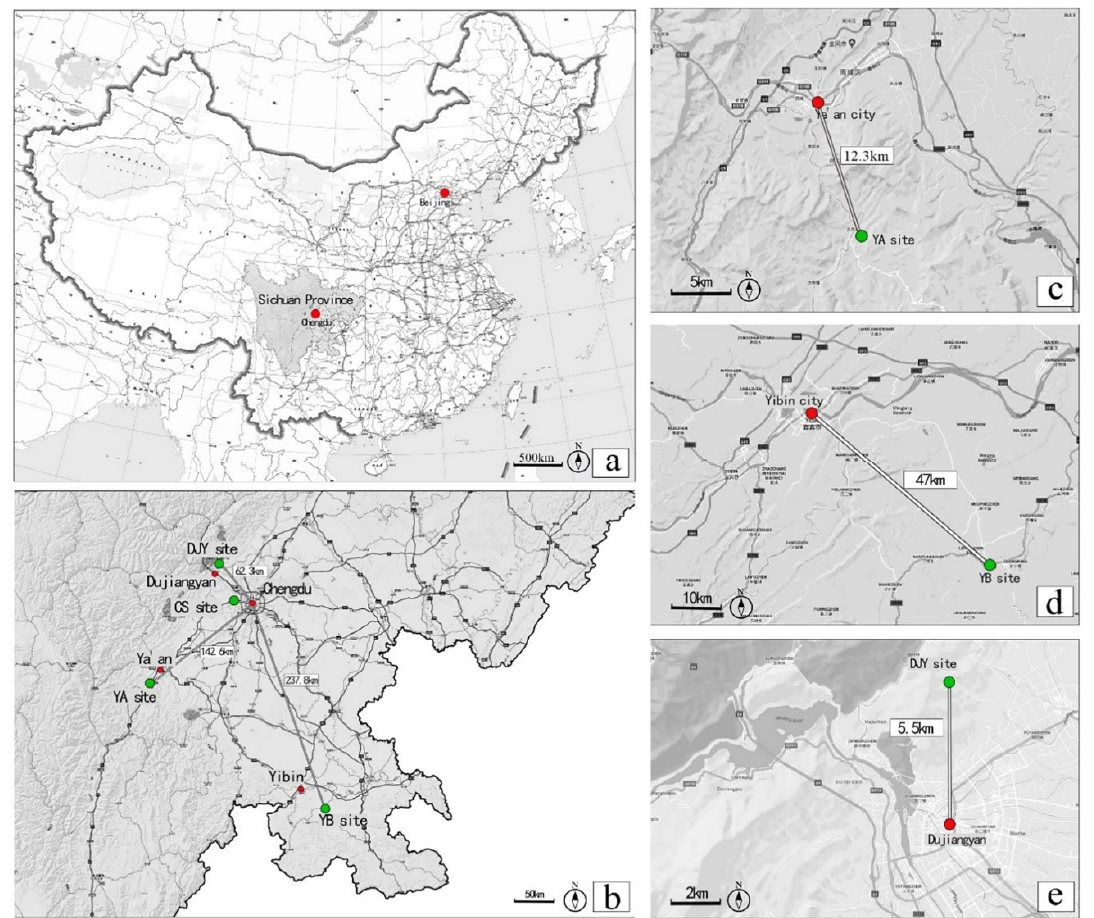
Figure 1. Maps of experimental sites. ( a ) Sichuan Province in China; and ( b ) the four sites in Sichuan Province; ( c ) Ya’an sites (YA); ( d ) Yibin sites (YB); ( e ) Dujiangyan sites (DJY). The red points mark the downtown areas, and the green points mark the location of each site.